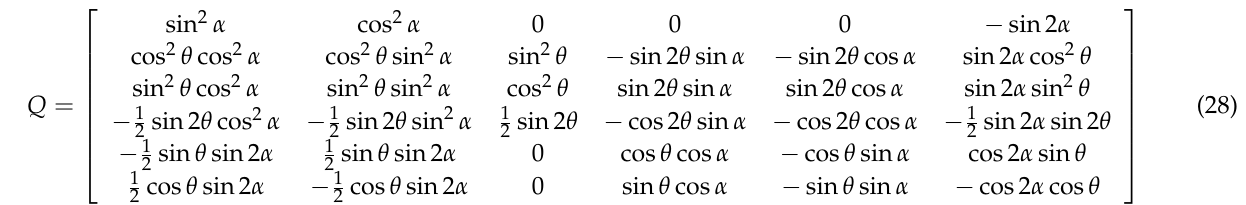
In Figure 13a, the value of the vertical stress increases when the formation dip angle increases from 0 ◦ to 90 ◦ , while the opposite trend can be observed in Figure 13b,c. The greater the formation dip angle is, the lower the value of horizontal stress and shear stress. It can be seen that the formation dip angle has prominent effects on the distribution of the stress. The relationship is due to the changes of the formation dip, and the direction of stresses deflects and forms some range of stress redistribution.